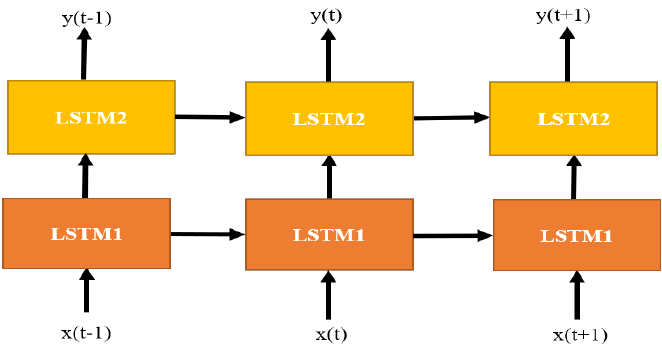
Figure 5. Double-layered LSTM.